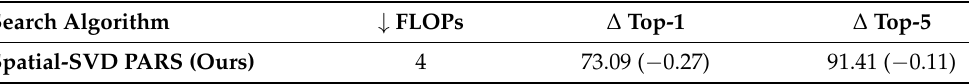
FLOPs ∆ Top-1 ∆ Top-5 ↓ 0.27) 91.41 ( 0.11) − −